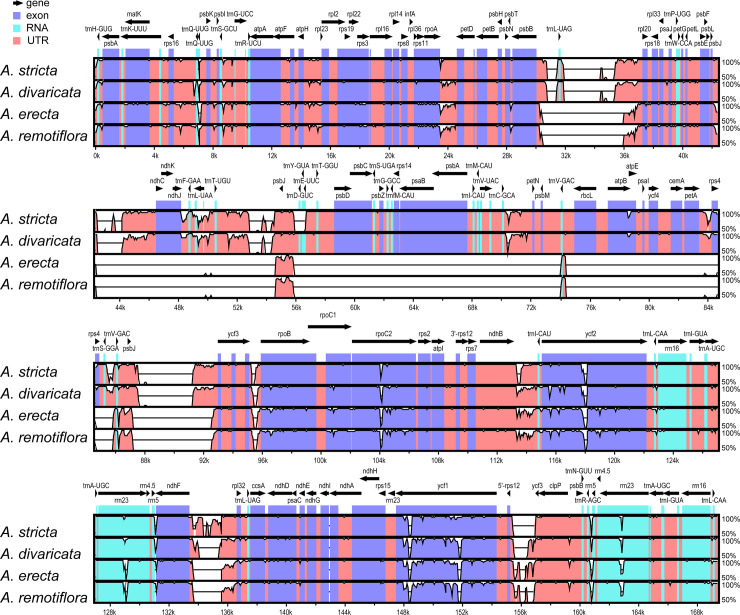
Visualization of alignment of five Adenophora chloroplast genomes using A. racemosa as a reference.The vertical scale indicates the percent identity, ranging from 50% to 100%. Coding regions, RNAs, and non-coding regions are marked in purple, sky blue, and red, respectively.